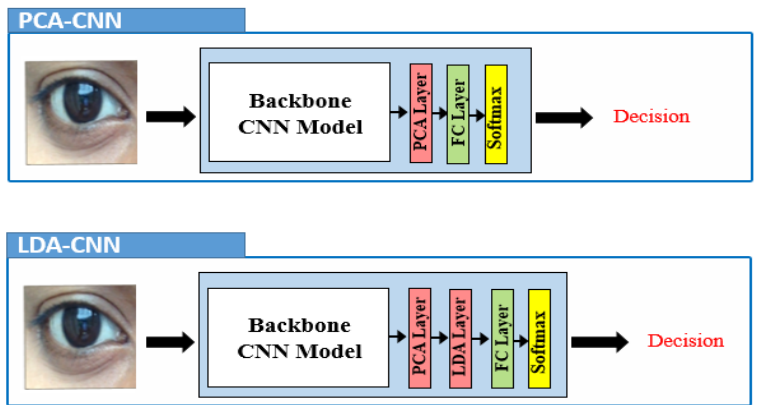
Figure 4. General framework of PCA-CNN and LDA-CNN (proposed) models.